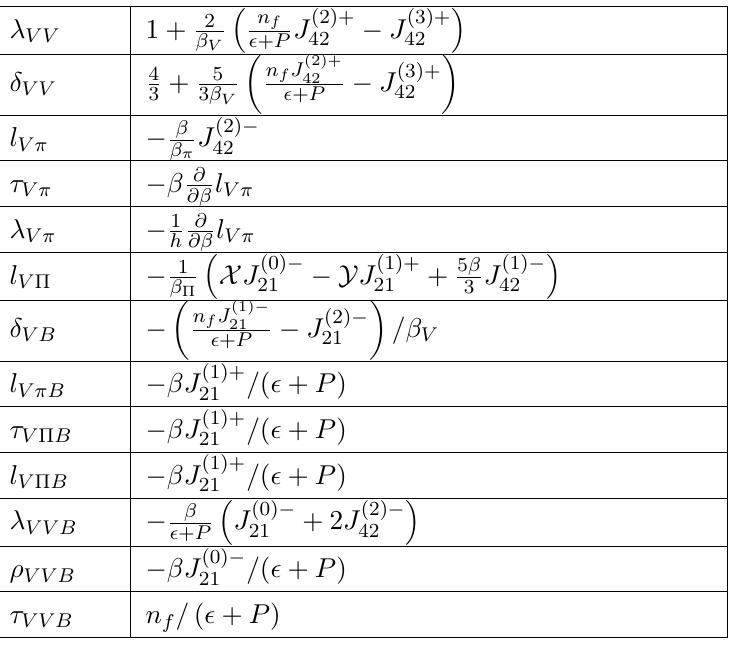
Table 4 . Transport coefficients appearing in diffusion equation eq.